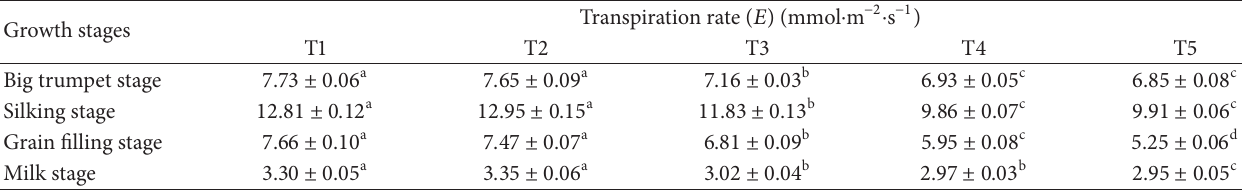
Table 4: Effects of Si application on transpiration rate ( 𝐸 ) in leaves of